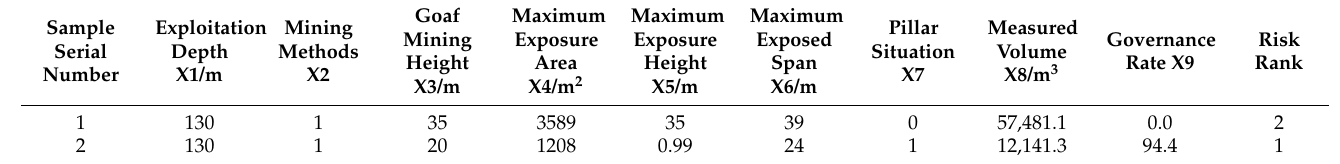
Table 1. Influencing factors of goaf stability and partial samples of the risk